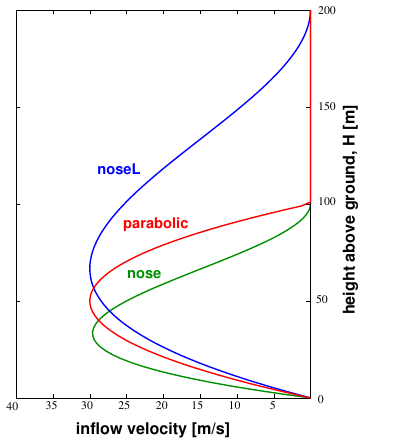
Figure 6. Normal inflow velocities at the eastern boundary, resem- bling the katabatic wind front.